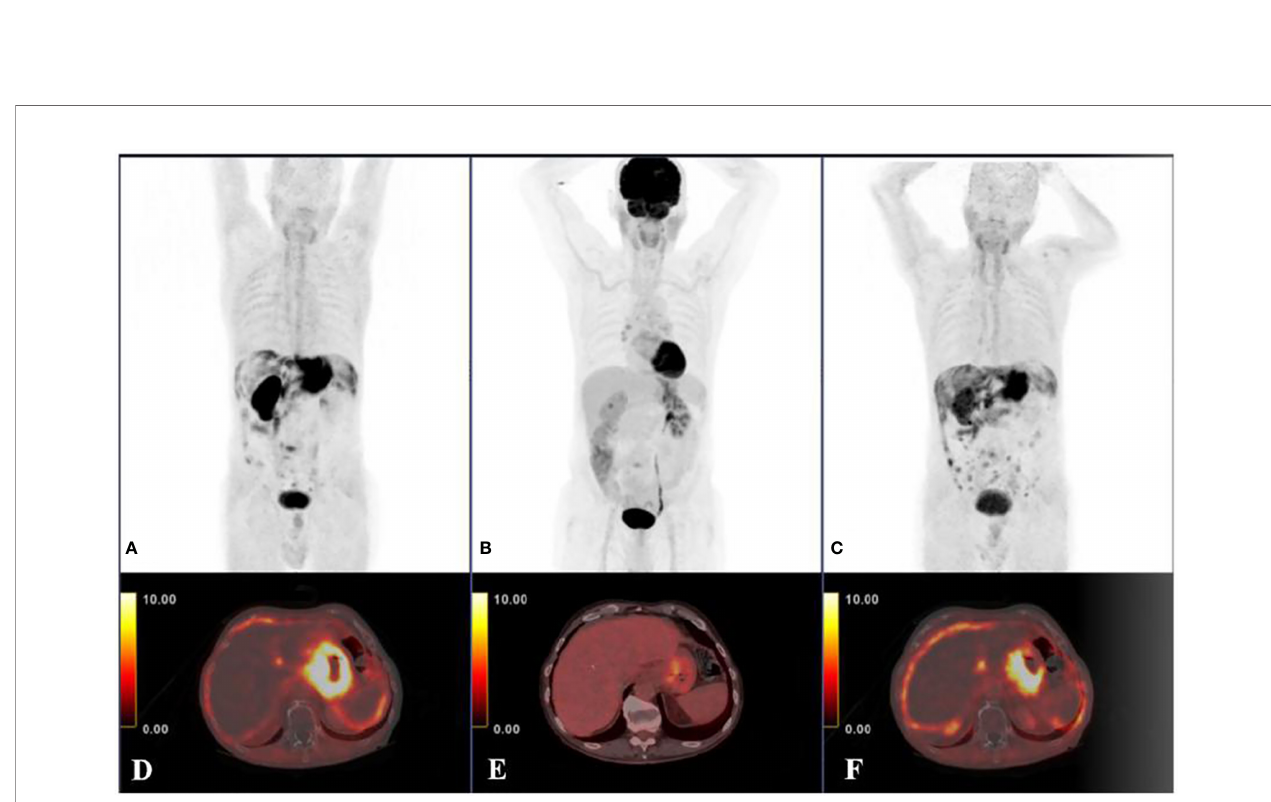
FIGURE 2 | Another 78-year-old male diagnosed with poorly differentiated gastric adenocarcinoma, 68 Ga-FAPI-04 PET/CT (A, D) and 18 F-FDG PET/CT scans (B, E) revealed highly uptake of FAPI in the primary tumor and peritoneal carcinomatosis compared with FDG (primary tumor SUVmax 23 and 6.8; primary tumor tumor-to-background ratio;11.5 and 3.8; peritoneal-carcinomatosis SUVmax 7.5 and 2.3, respectively). The 68 Ga-FAPI-04 PET/CT examination after 4 months of chemotherapy (C, F) showed the disease progression of this patient. The results demonstrated that 68 Ga-FAPI-04 PET/CT was superior to 18 F-FDG PET/CT in detecting primary gastric adenocarcinoma and peritoneal carcinomatosis with a gastric cancer origin. With permission from Kuten et al.